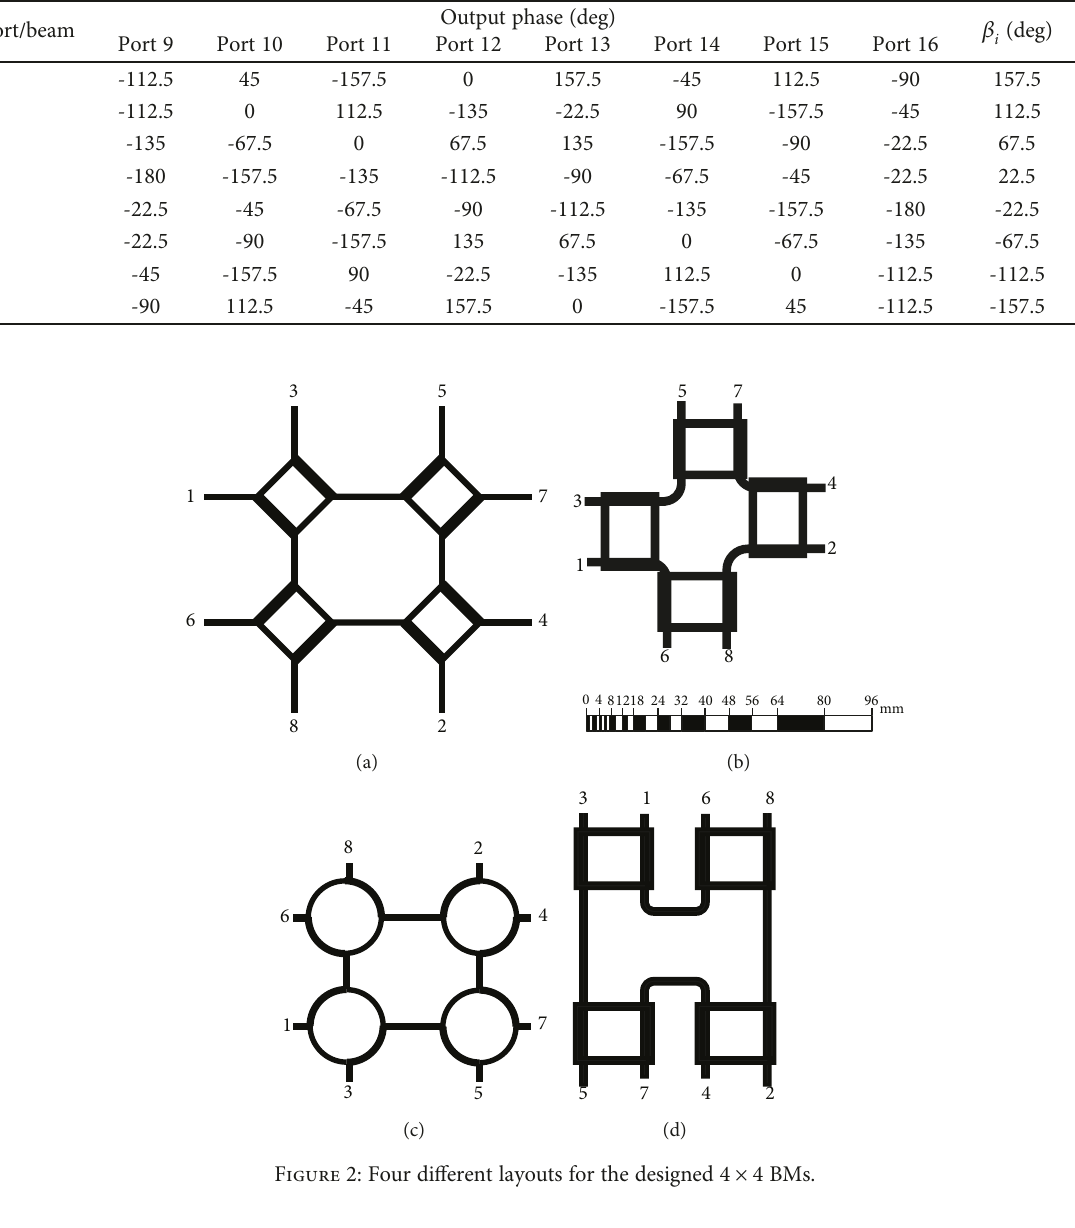
i , and beam directions